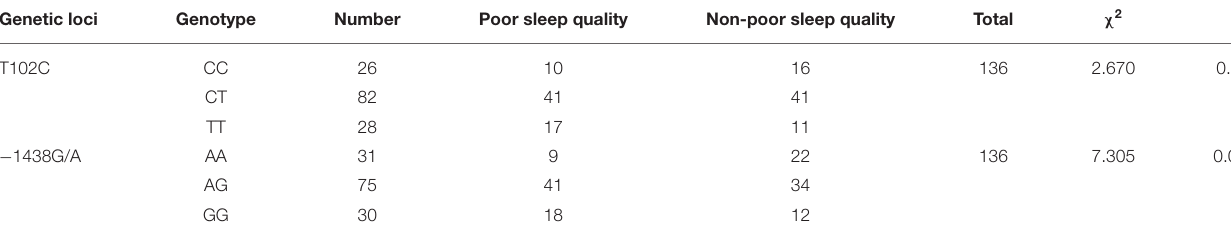
TABLE 6 | Distribution of T102C and − 1438G/A genotypes across different sleep quality groups. Genetic